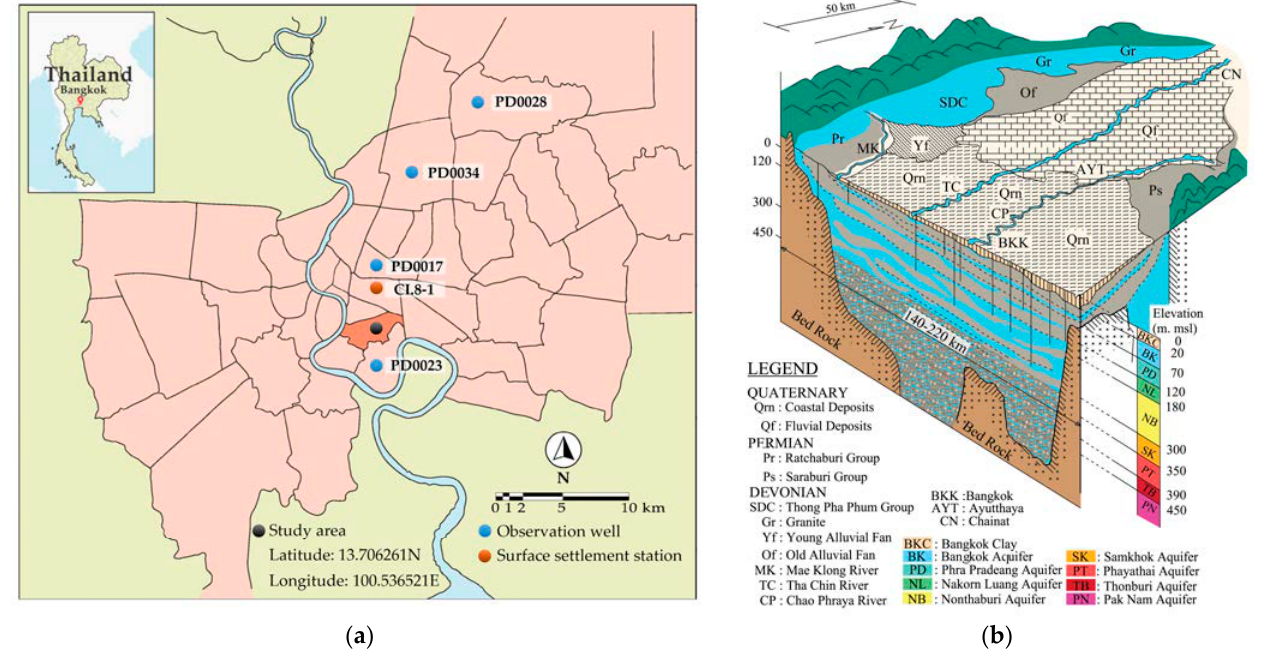
Figure 1. Location and Geology of Bangkok area: ( a ) Map showing study area in Bangkok and sampling points; ( b ) stratigraphy of Lower Central Plain basin.